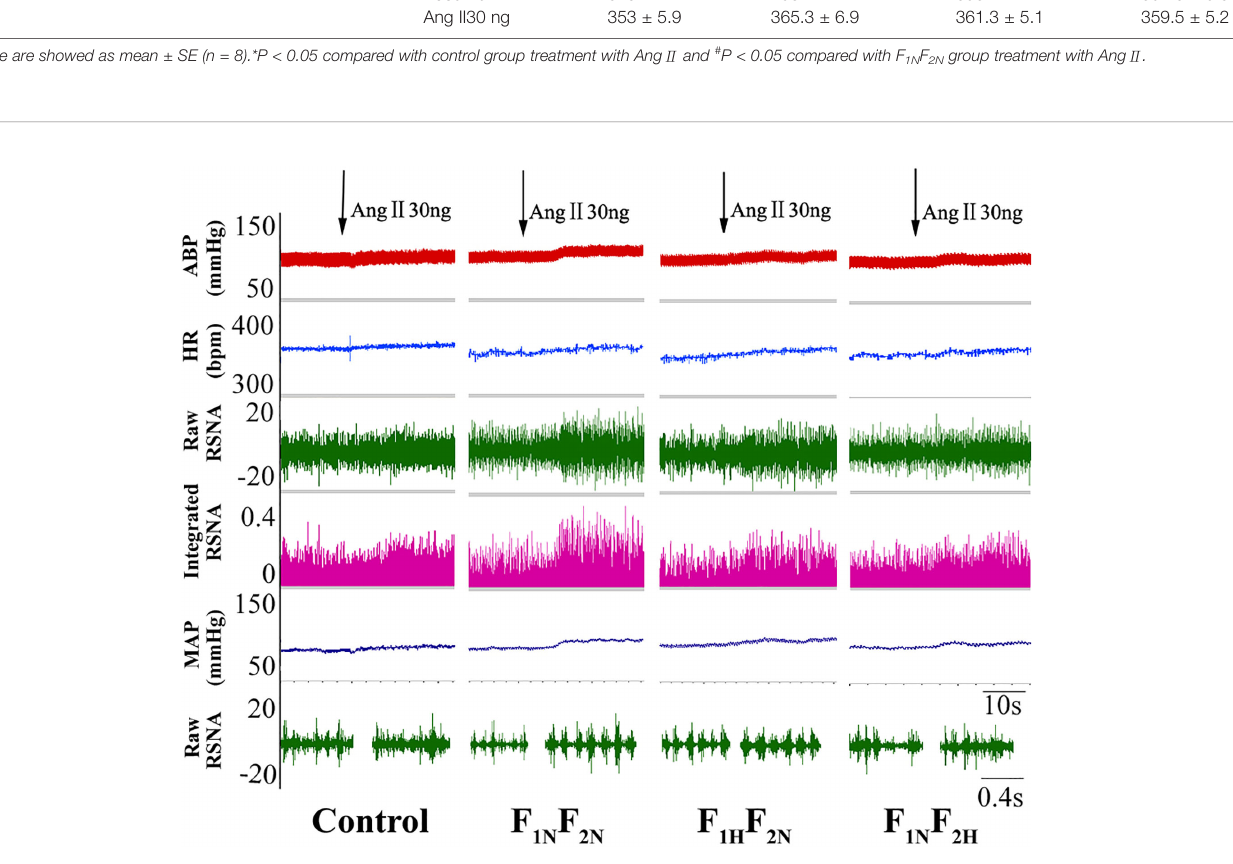
FIGURE 3 | Original trace recordings showing microinjection of Ang II (30 ng, 5 m L) into LVs increased MAP, HR, and RSNA in female offspring from the control, F 1N F 2N (offspring of RVH rats), F 1H F 2N (RVH rats treated with NaHS, offspring without NaHS), and F 1N F 2H (maternal RVH rats treated without NaHS and offspring with NaHS after weaning) groups ( n =